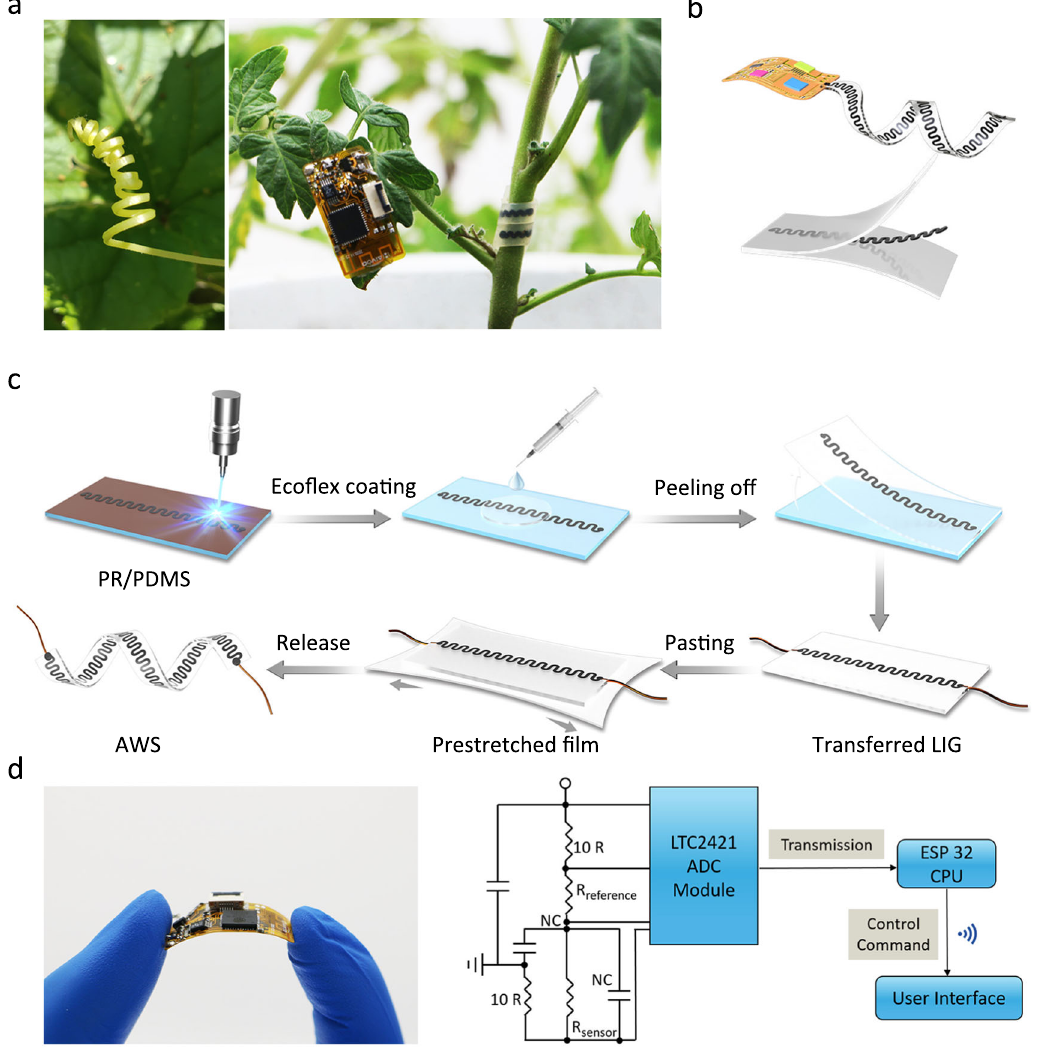
Fig. 1 Schematics of the IPWS for plant pulse monitoring. a The optical images of plant tendril and IPWS on tomato seedlings. b Schematic diagram of the AWS sensor integrated with the fl exible printed circuit. c Schematic diagram of the fabrication of AWS sensor. d The optical image of bent printed circuit, and schematic illustration of the system-design for the signal transduction, processing and wireless transmission from the AWS sensor to the user